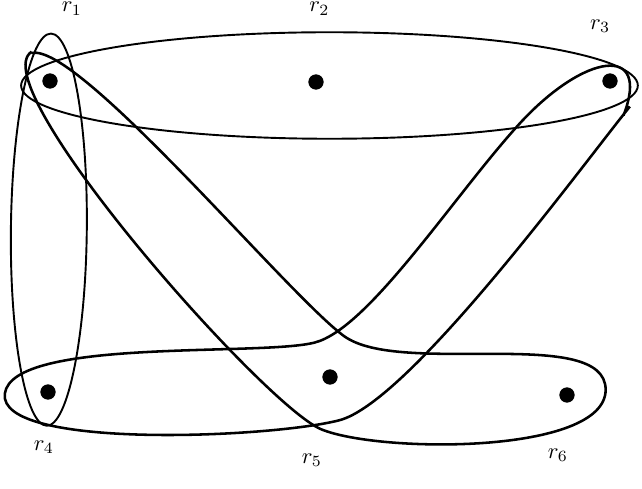
( α 4 e ι Θ 4 , β 4 e ι Φ 4 , γ 4 e ι Ψ 4 ) -level Figure 5. H